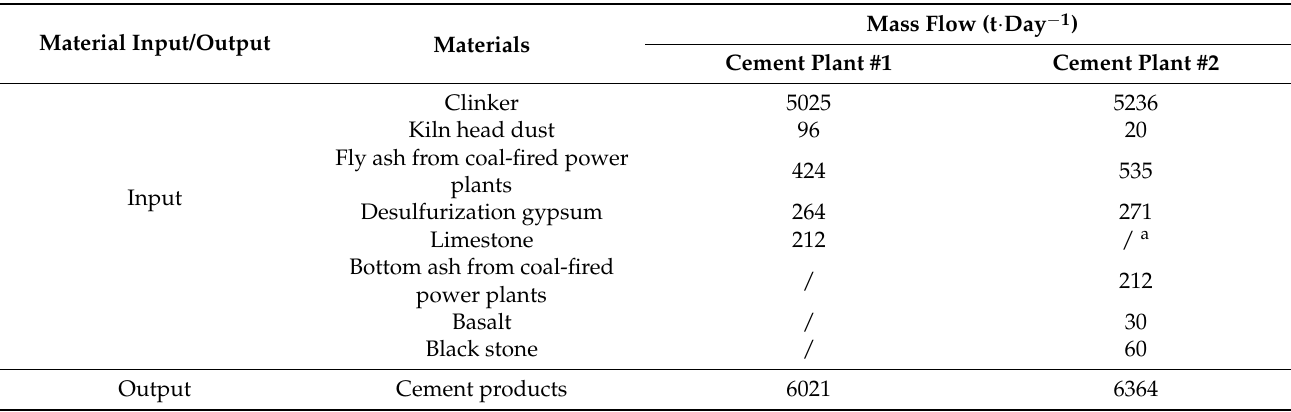
Table A4. Mass flow of solid materials during the clinker-to-cement production process of the